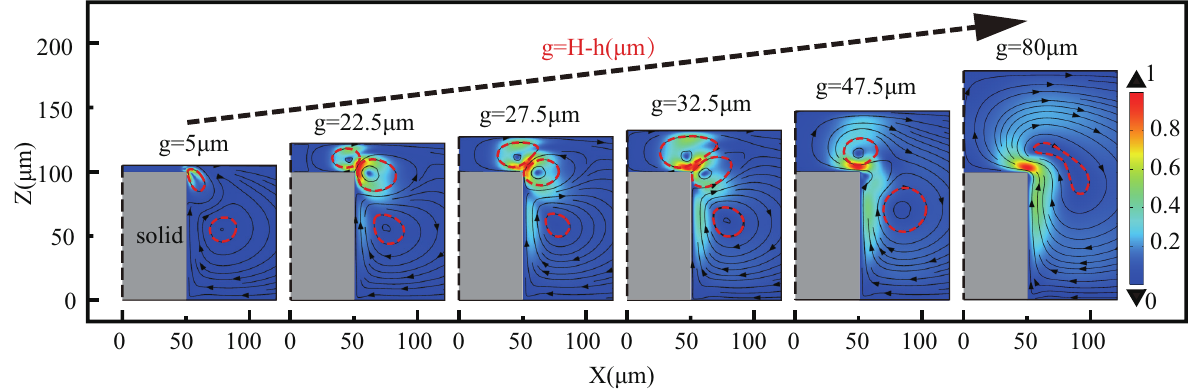
Figure 4. Changes in the acoustic streaming patterns with the gap. The vortexes are all reverse − symmetrical, such as red dotted lines, and show only half, with black dotted lines be- ing the axis of the symmetry. Among them, the high-speed vortex is a vortex with a velocity greater than 0.5, otherwise it is a low-speed vortex. The legend of each cloud atlas divided by the respective maximum streaming